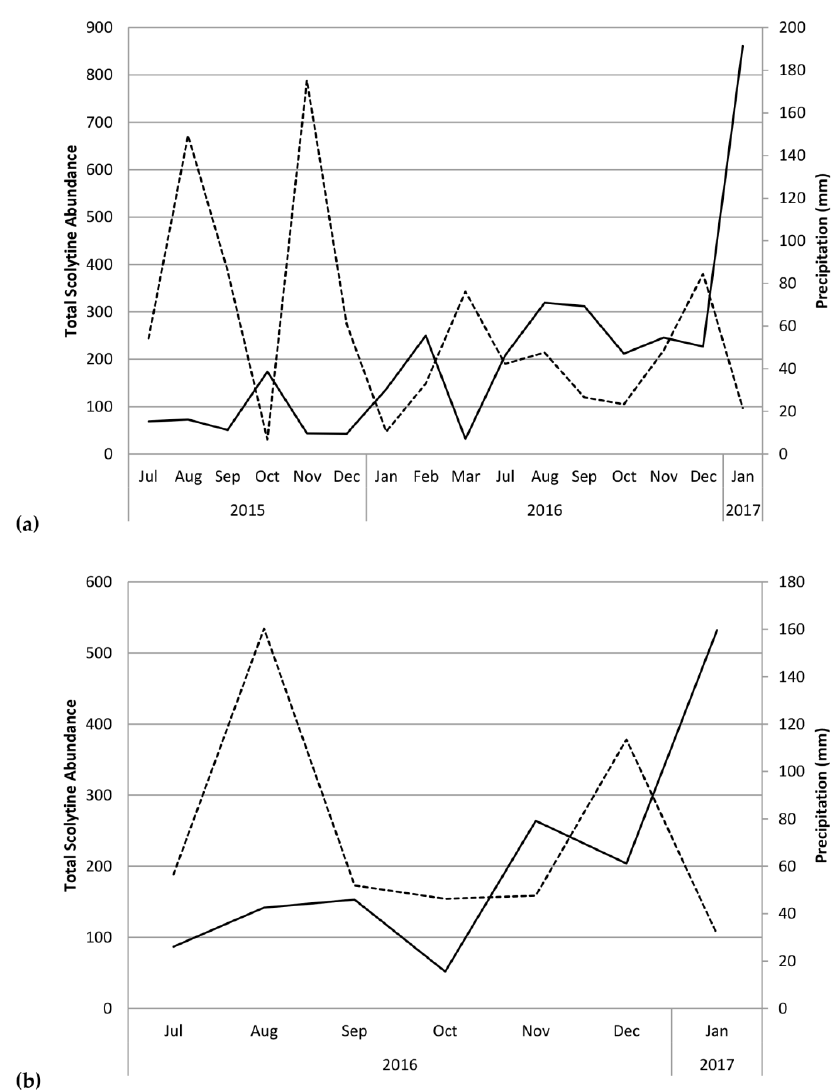
Figure 4. Total monthly scolytine abundance (solid line) and precipitation (dashed line) at ( a ) the